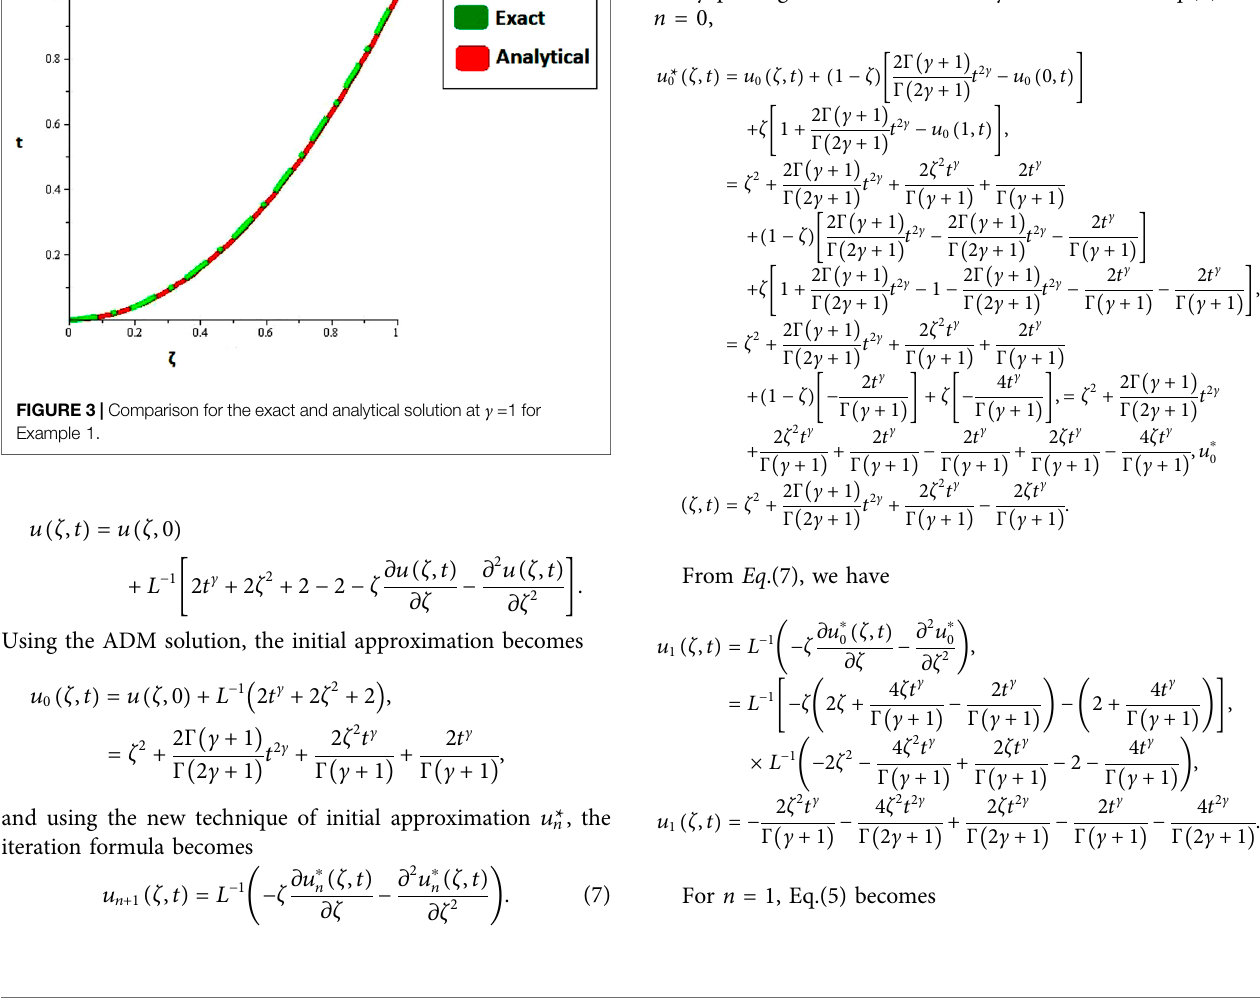
Frontiers in Physics |